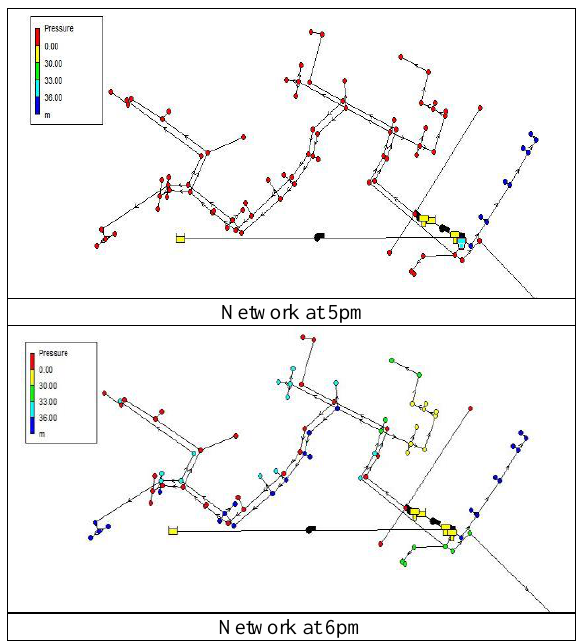
Figure 9 Network at 5pm shows negative pressure and gets